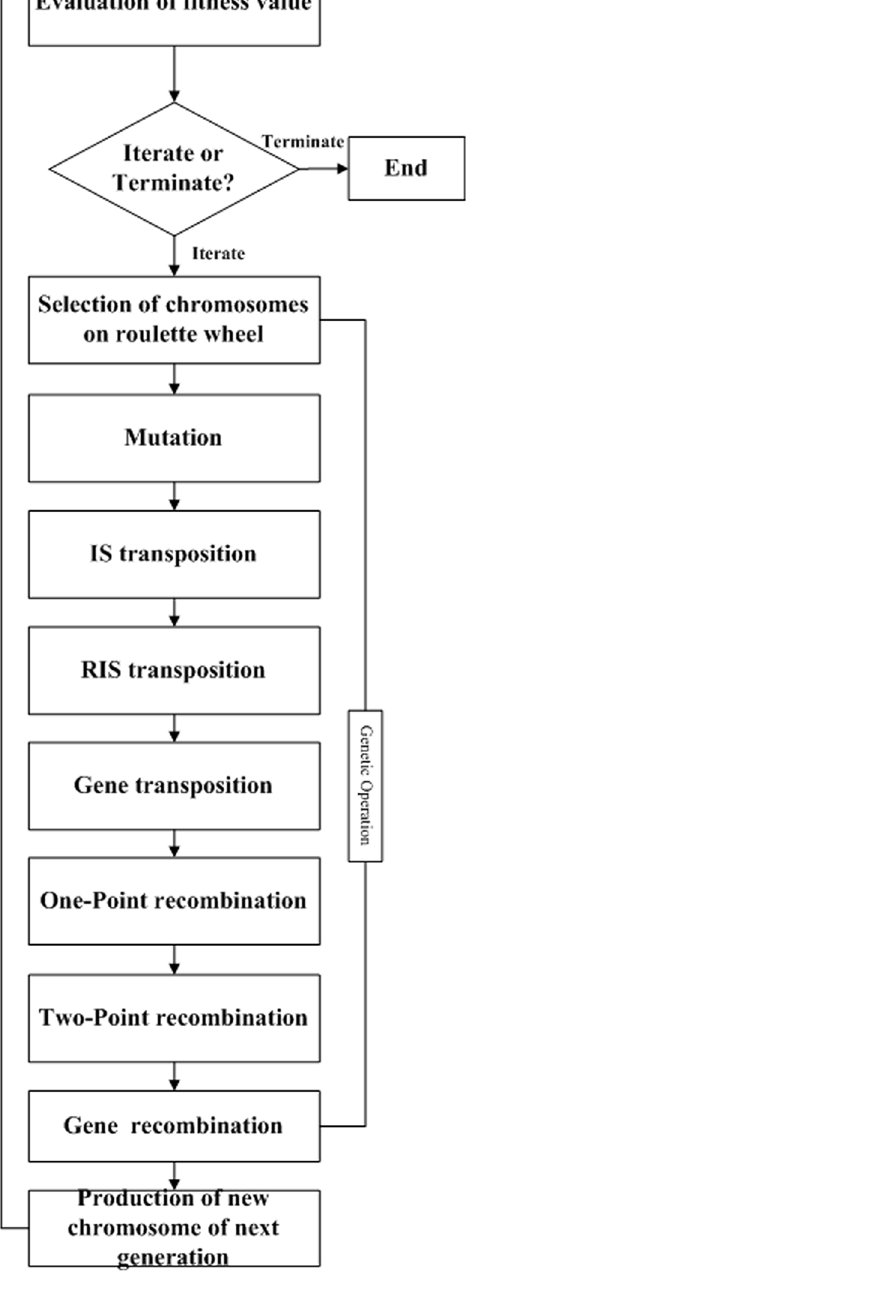
Fig 1. The flow chart of traditional GEP.